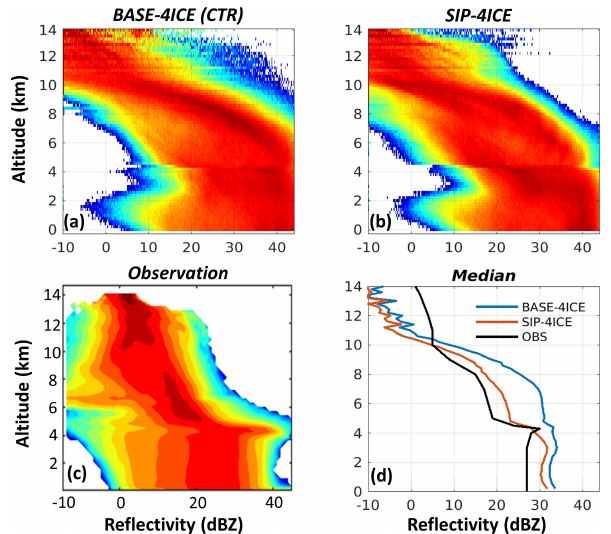
Figure 12. Radar reflectivity distribution frequency for (a) CTR with four ice categories between 60 and 180min after model ini- tiation. Panel (b) is the same as panel (a) but for the model with SIP included. Panel (c) is from all of the observational data from the NRC Convair 580 aircraft during the HAIC-HIWC campaign. Panel (d) is the median value for each altitude for the two model simulations and